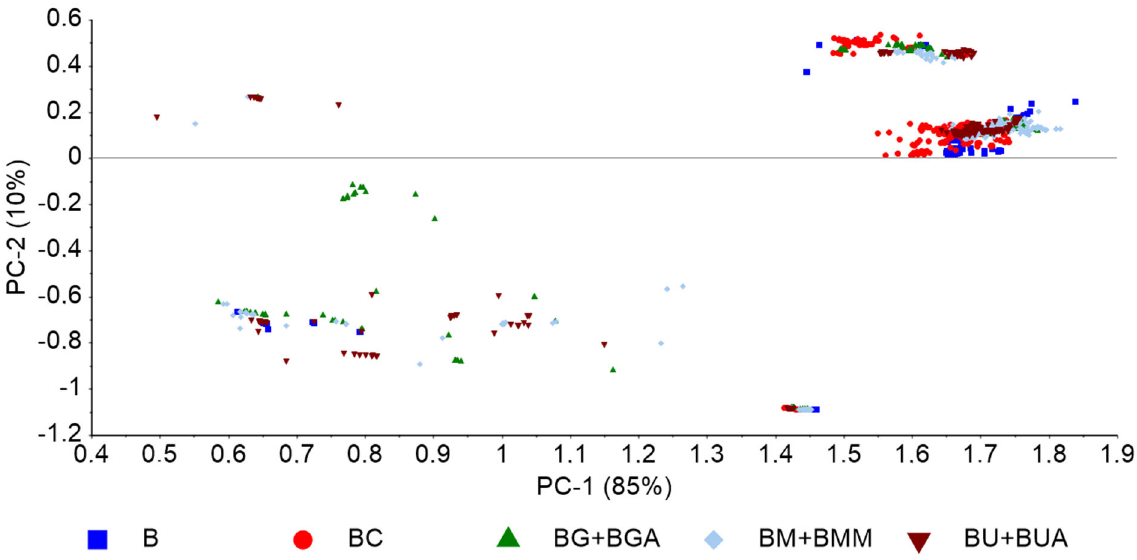
Figure 4. PCA based on nirU data, preprocessed with baseline correction and maximum normaliza-